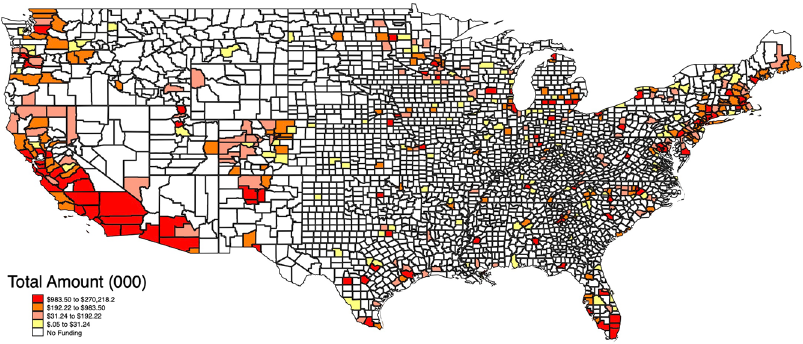
Figure 1: Total aggregated philanthropic funding for immigration related services from 2008 to